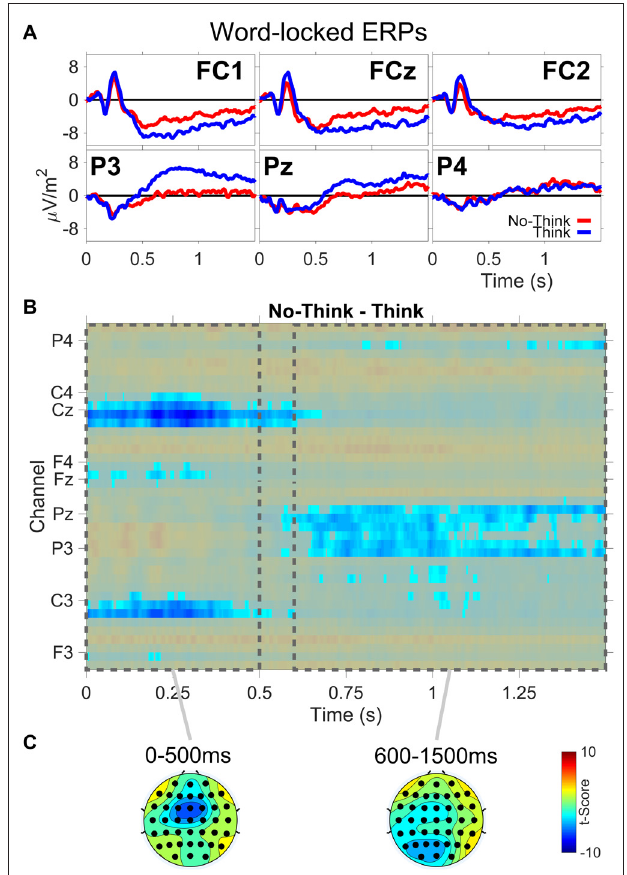
FIGURE 3 | Word-locked event-related potential (ERP) data. (A) ERP waveforms from three frontal (FC1,FCz,FC2) and three parietal (P3,Pz,P4) electrode channels. (B) No-Think—Think significant t -scores ( p < 0.05) at all electrodes and time points. (C) Topographies of t -scores for